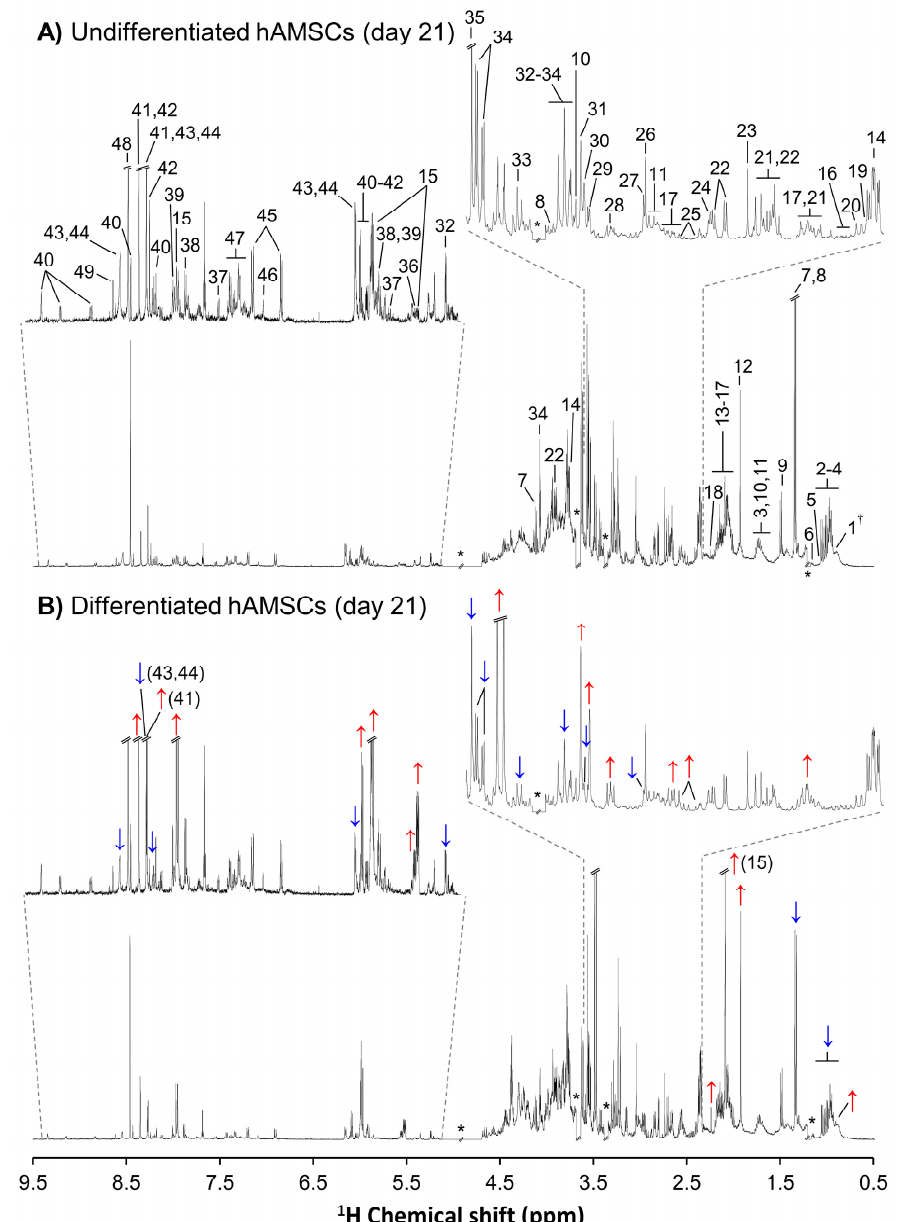
Figure 1. Average 1 H NMR spectra of polar extracts obtained from ( A ) undifferentiated and ( B ) osteodifferentiated hAMSC of donor 1 at day 21. Apparent metabolic variations with differentiation are identified in ( B ) with blue and red arrows indicating decreases and increases, respec- tively. †, resonances not observed in day 0 samples; *, excluded spectral regions. Peak assignments: 1. pantothenate, 2. isoleucine, 3. leucine, 4. valine, 5. propionate, 6. propylene glycol, 7.